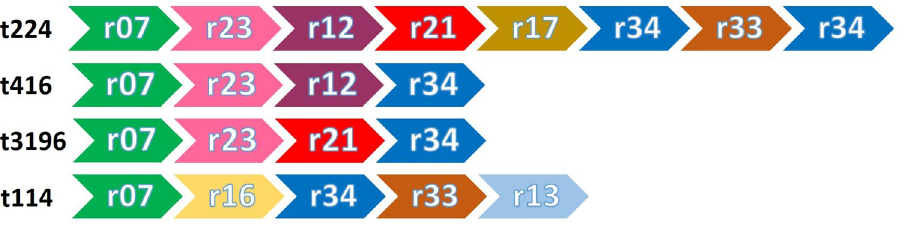
Figure 3. Schematic representation of the polymorphic VNTRs associated with identified spa -types. The order of identified VNTRs of the identified spa -types t224, t416, t3196 and t114 as detected in the present study isolates is schematically represented. The Figure was created with Microsoft PowerPoint 2016.